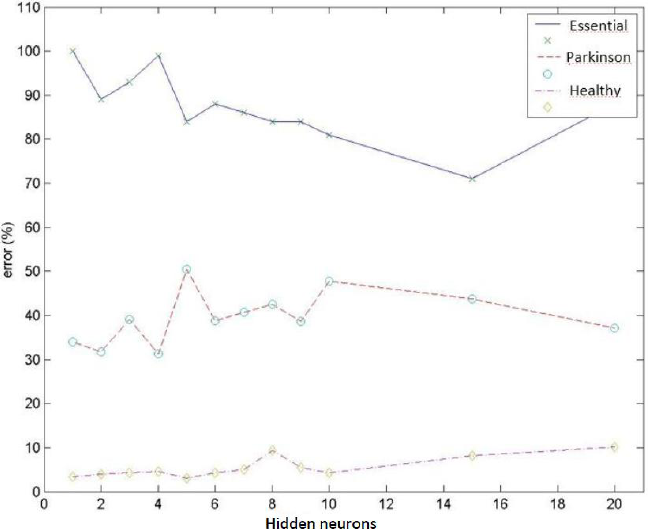
Figure 10. Error distribution for each type of pathology obtained using PSD